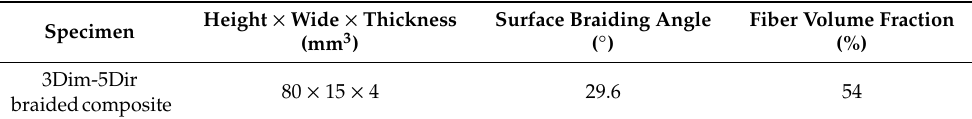
Table 1. Specifications of composites